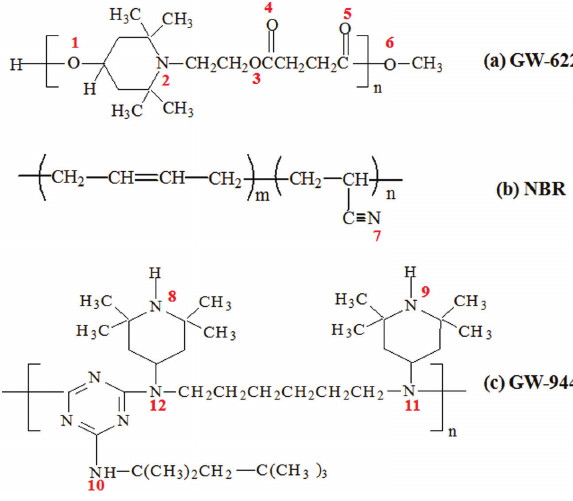
Figure 1: Molecular structures of (a) GW-622, (b) NBR and (c)